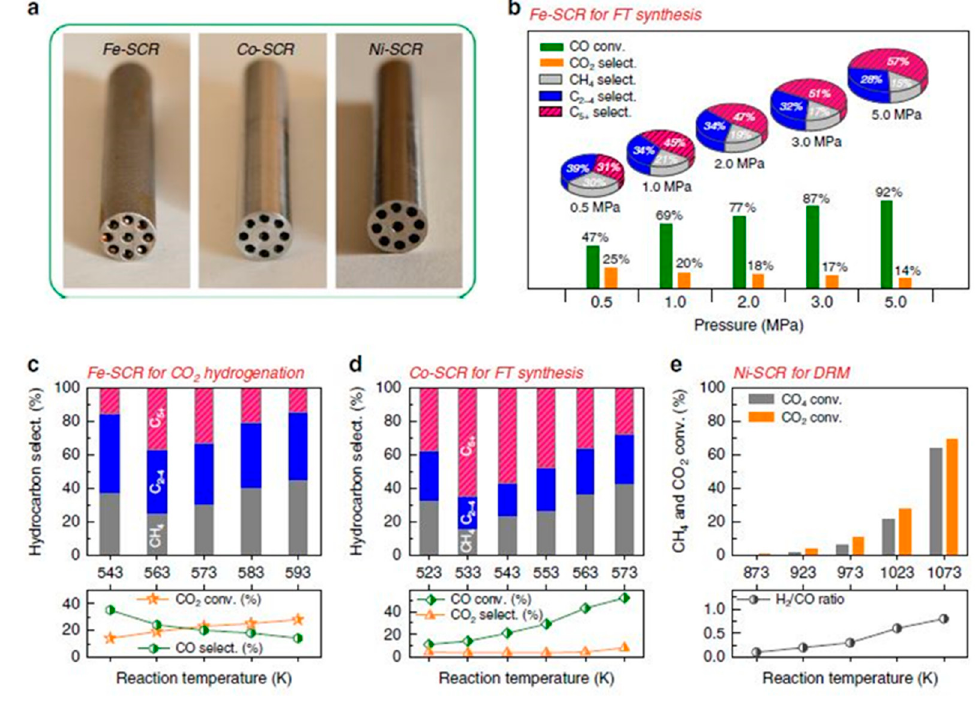
Figure 7. ( a ) The physical SCRs after polishing the outer surface. ( b ) Fe-SCR for F–T synthesis. ( c ) Fe-SCR for CO 2 hydrogenation. ( d ) Co-SCR for F–T synthesis. ( e ), Ni-SCR for CO 2 /CH 4 (dry reforming). Reproduced with permission from [130]. Copyright Nature, 2020.